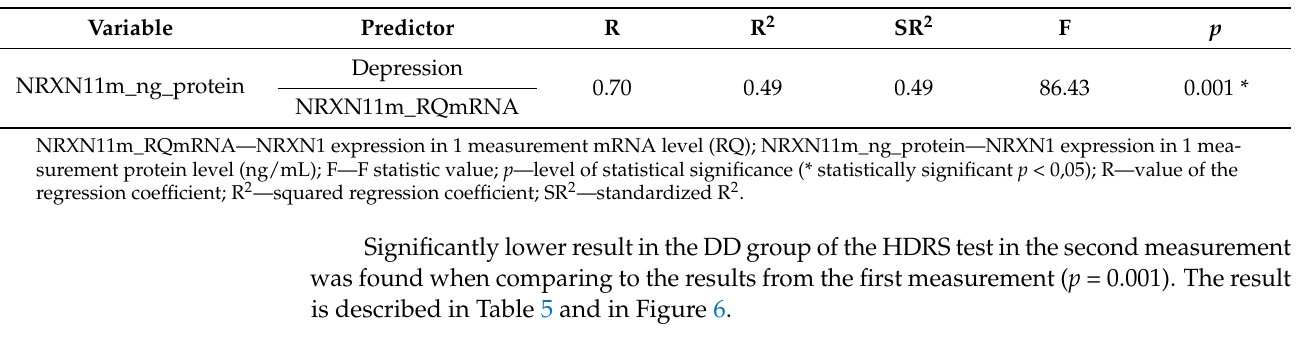
Table 5. Severity of depression in the experimental group—1 and 2 measurement.